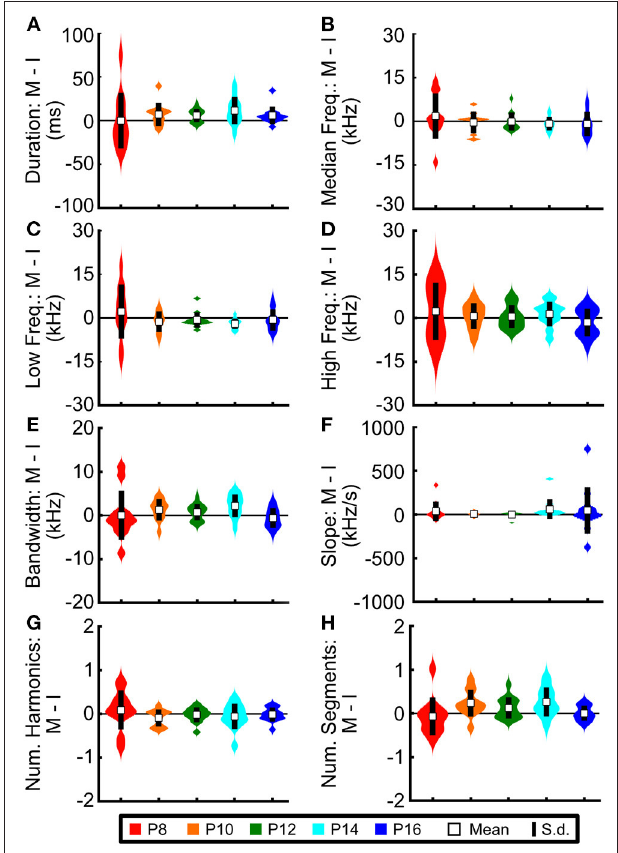
FIGURE 8 | Prairie vole pups do not modify the acoustic features of USVs across social contexts. Difference in average acoustic features for individual pups between the isolated context and the mother-present context for (A) duration, (B) median frequency, (C) low frequency, (D) high frequency, (E) bandwidth, (F) slope, (G) number of harmonics, and (H) number of segments per vocalization, calculated by subtracting the average value of each individual pup in the isolated context (I) from the same pup’s average value during the mother-present condition (M). No distributions differed significantly from zero (z-test, all z ≤